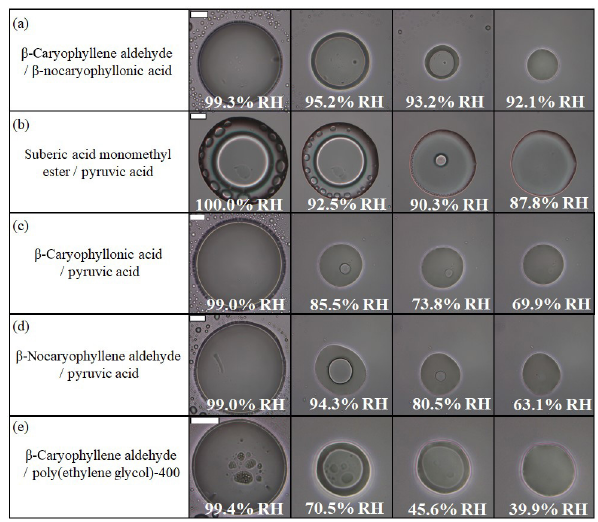
Figure 5. Optical images of two-component particles for in- creasing RH: (a) β -caryophyllene aldehyde– β -nocaryophyllonic acid, (b) suberic acid monomethyl ester–pyruvic acid, (c) β - caryophyllonic acid–pyruvic acid, (d) β -nocaryophyllene aldehyde–pyruvic acid, and (e) β -caryophyllene aldehyde– polyethylene glycol-400. The particles are the same ones in Fig. 5. The last columns indicate the upper RH boundary for LLPS (LLPS upper ) with increasing RH. The scale bar is